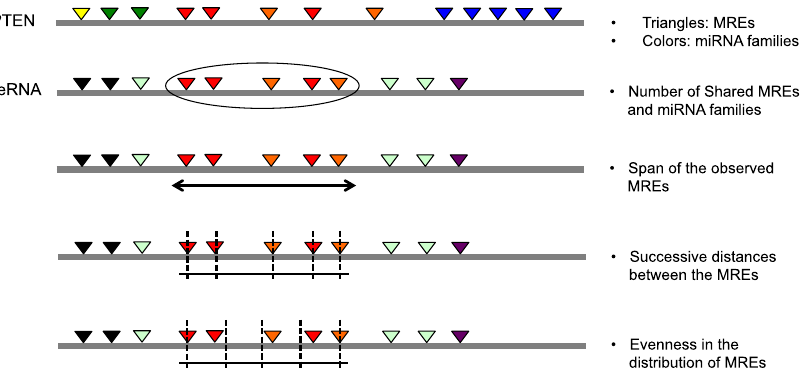
Figure 1. Features of ceRNAs. Figure shows a schematic representation of ceRNA features derived from MRE locations. Colors represent miRNA families and triangles represent